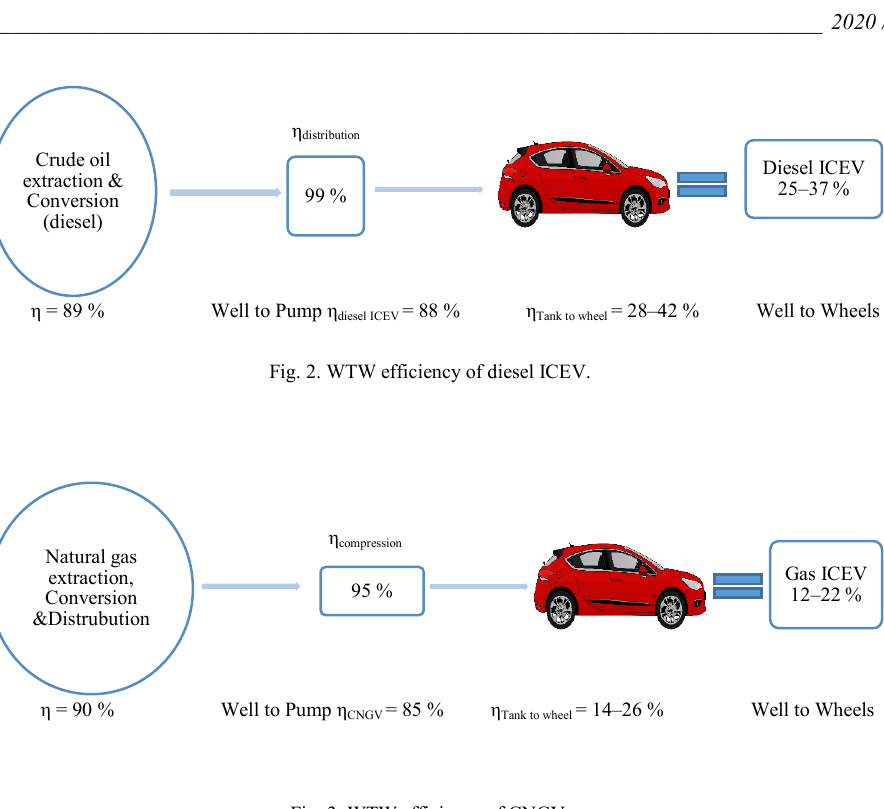
Fig. 3. WTW efficiency of